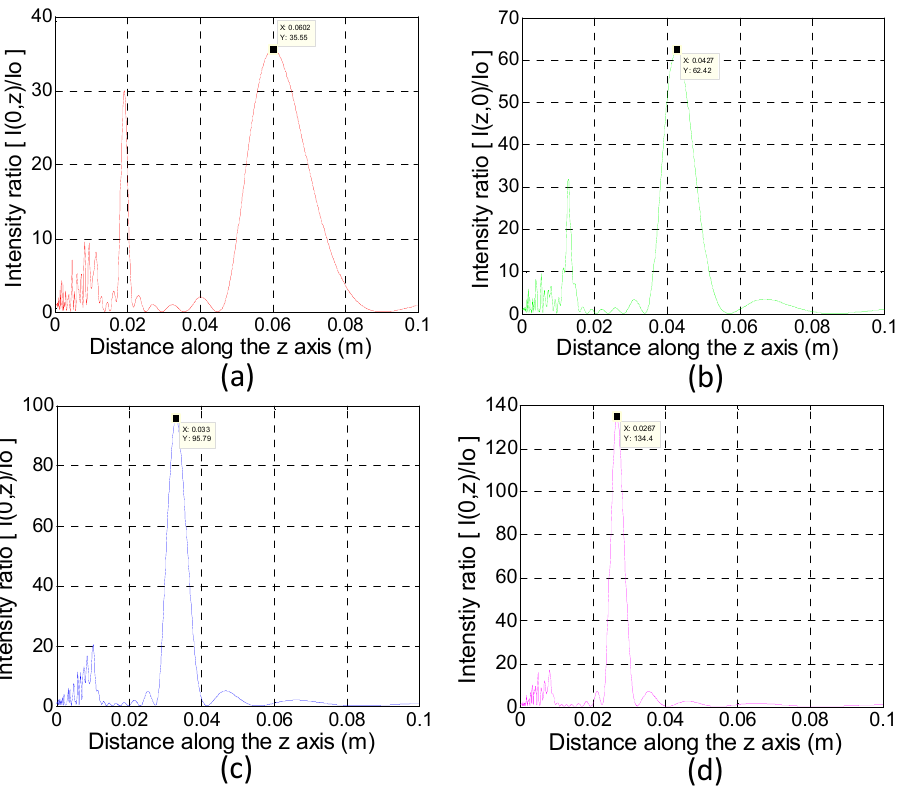
Figure 3. Calculated intensity ratios of four kinds of zone plate designs. ( a ) n = 5; ( b ) n = 7; ( c ) n = 9; ( d ) n = 11.